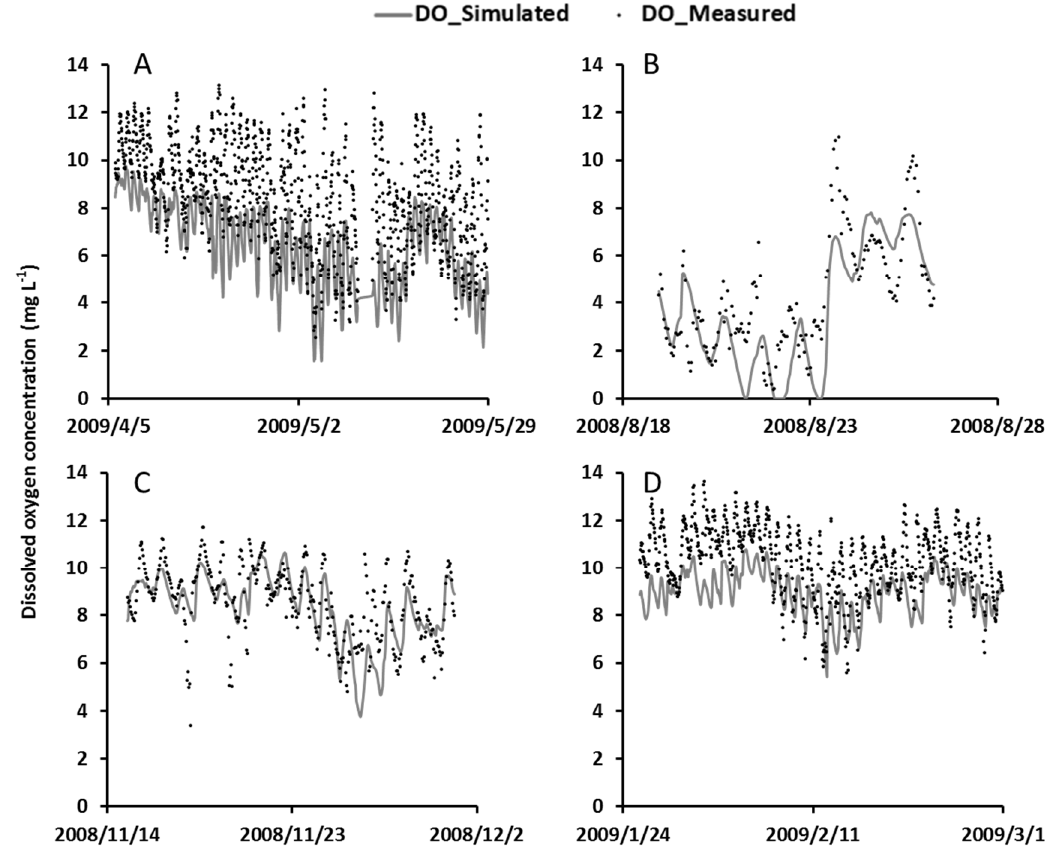
Figure 3. Hourly simulation of dissolved oxygen concentration in model validation for ( A ) spring; ( B ) summer; ( C ) fall; and ( D ) winter.